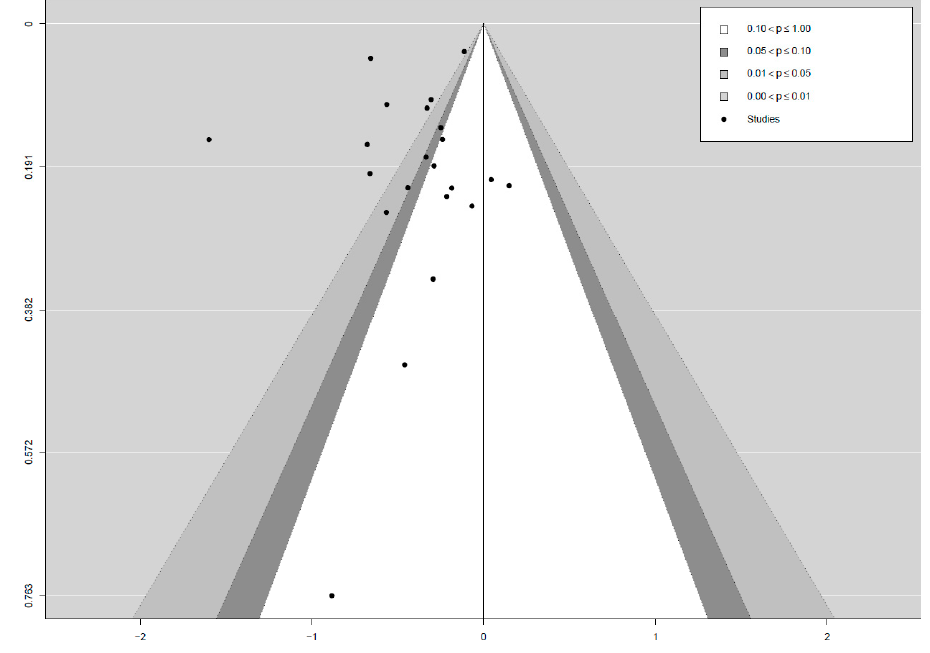
Figure 7. Funnel plot.